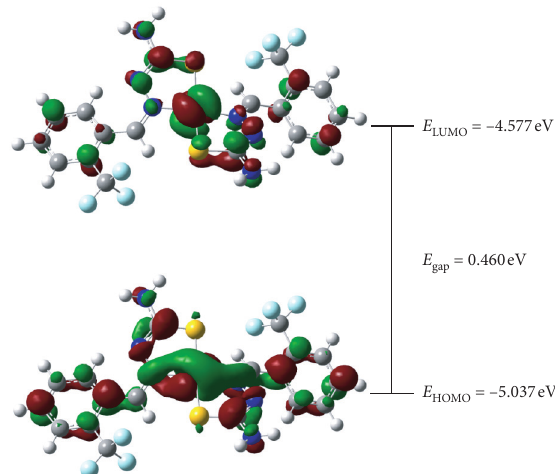
Figure 5: HOMO-LUMO surfaces and energy gap for NiL